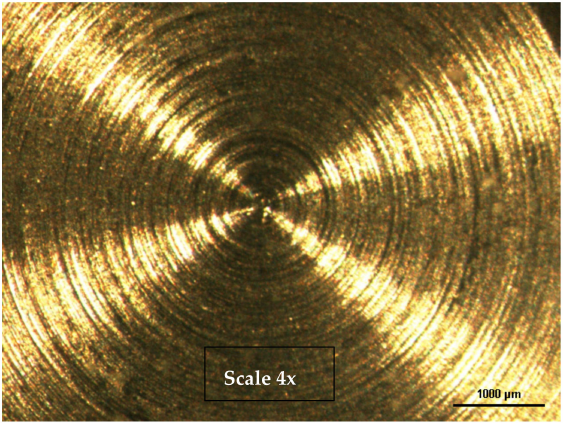
Figure 11. Lower JB on z axis before the test, AA 6081 spindle.